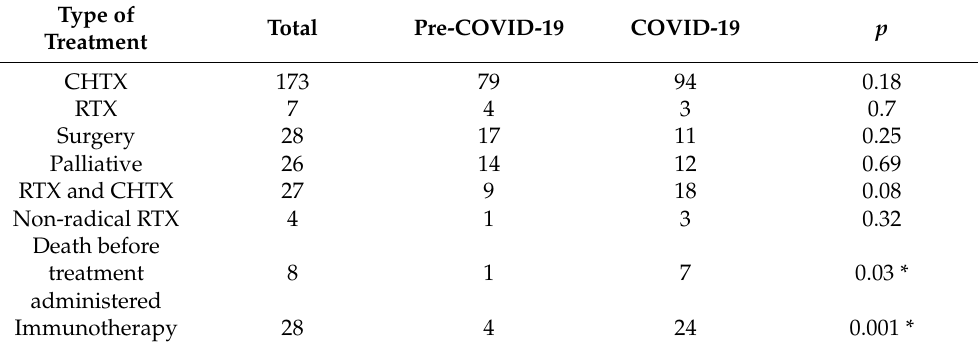
Death before treatment 8 0.03 * administered Immunotherapy